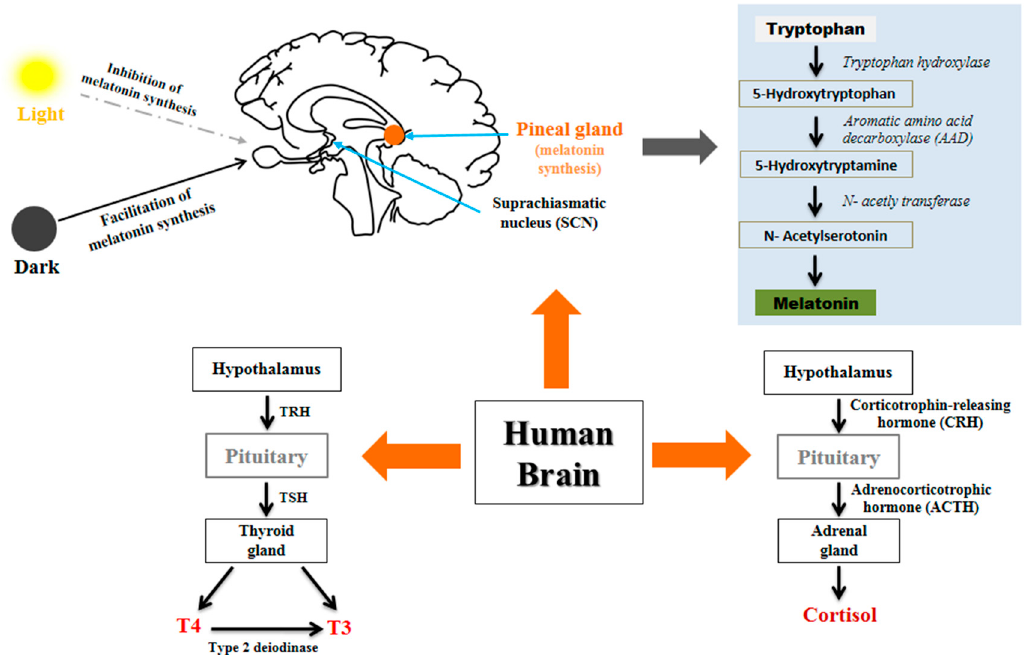
Figure 1. The synthesis of melatonin, thyroid-stimulating hormone (TSH), and cortisol, depending on circadian rhythm. The expression of cortisol, a steroid hormone produced in the adrenal gland, is tightly regulated by circadian rhythms in various mammals, including humans. The primary rhythm of this cycle is controlled by the suprachiasmatic nucleus (SCN), located in the hypothalamus. The secretion pattern of cortisol is coordinated by the hypothalamic–pituitary–adrenal (HPA) axis and the hippocampus. This HPA axis receives input from the SCN, from which it controls corticotrophin-releasing hormone (CRH) release in the paraventricular nucleus. From there, adrenocorticotrophic hormone (ACTH) is released from the corticotropes in the anterior pituitary by stimulating CRH. In normal individuals, cortisol levels fall to low or even undetectable levels around midnight, followed by peak expression around at 08:30.